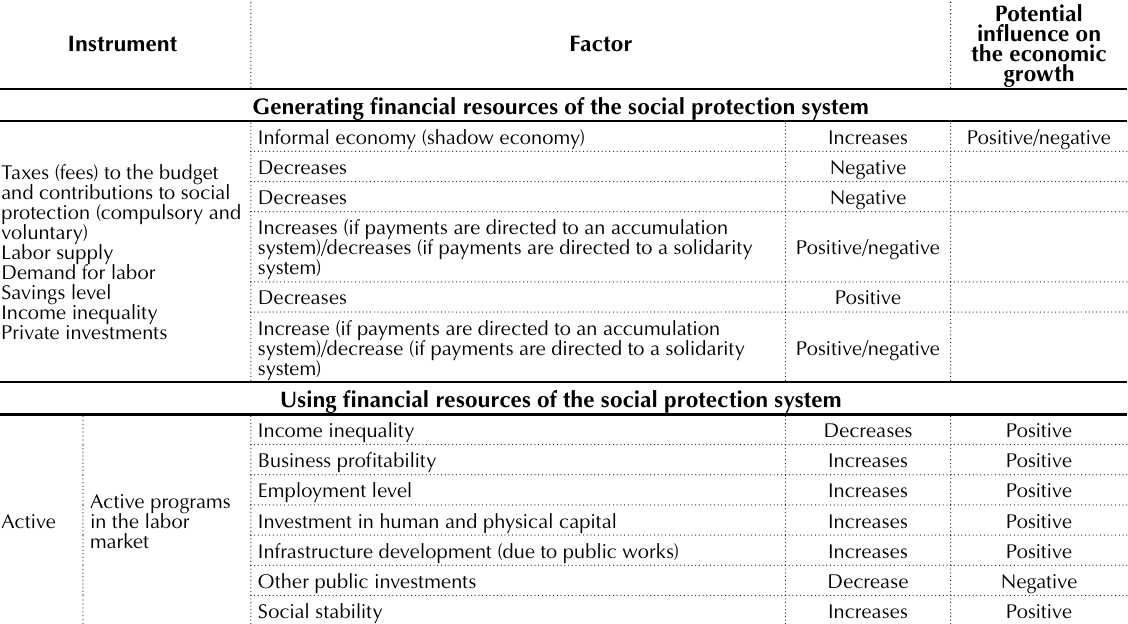
Table 1. Analysis of the social protection impact on the factors determining economic